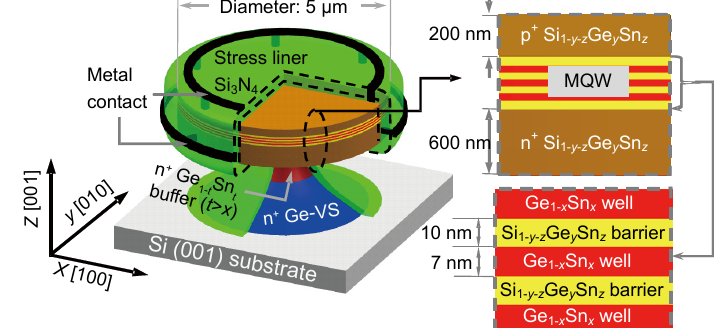
Fig. 7 | 3D schematic of the Ge 1- x Sn x /Si 1- y - z Ge y Sn z MQW laser wrapped in a Si 3 N 4 liner stressor . Figure reproduced from ref. 36 ,